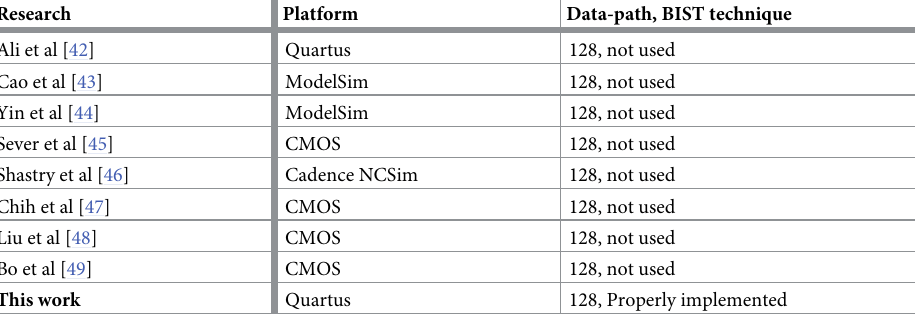
Table 2. Comparison results of the AES in terms of BIST